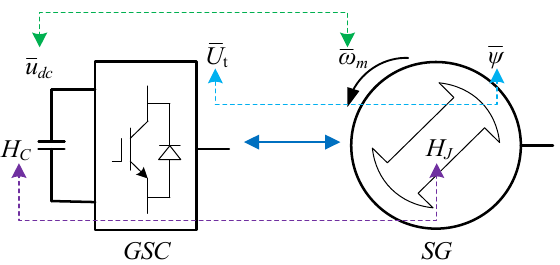
Figure 2. Kinetic similarity relationships between the GSC and the SG.